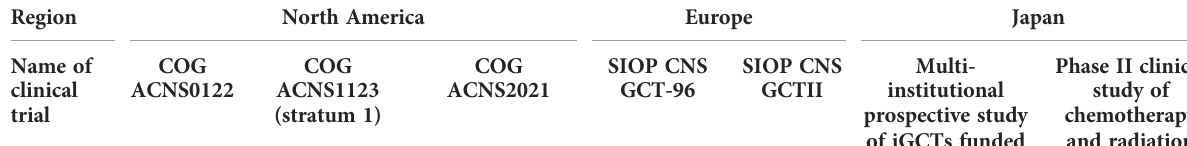
TABLE 3 Representative clinical trials for non-germinomatous germ cell tumors (NGGCTs) across